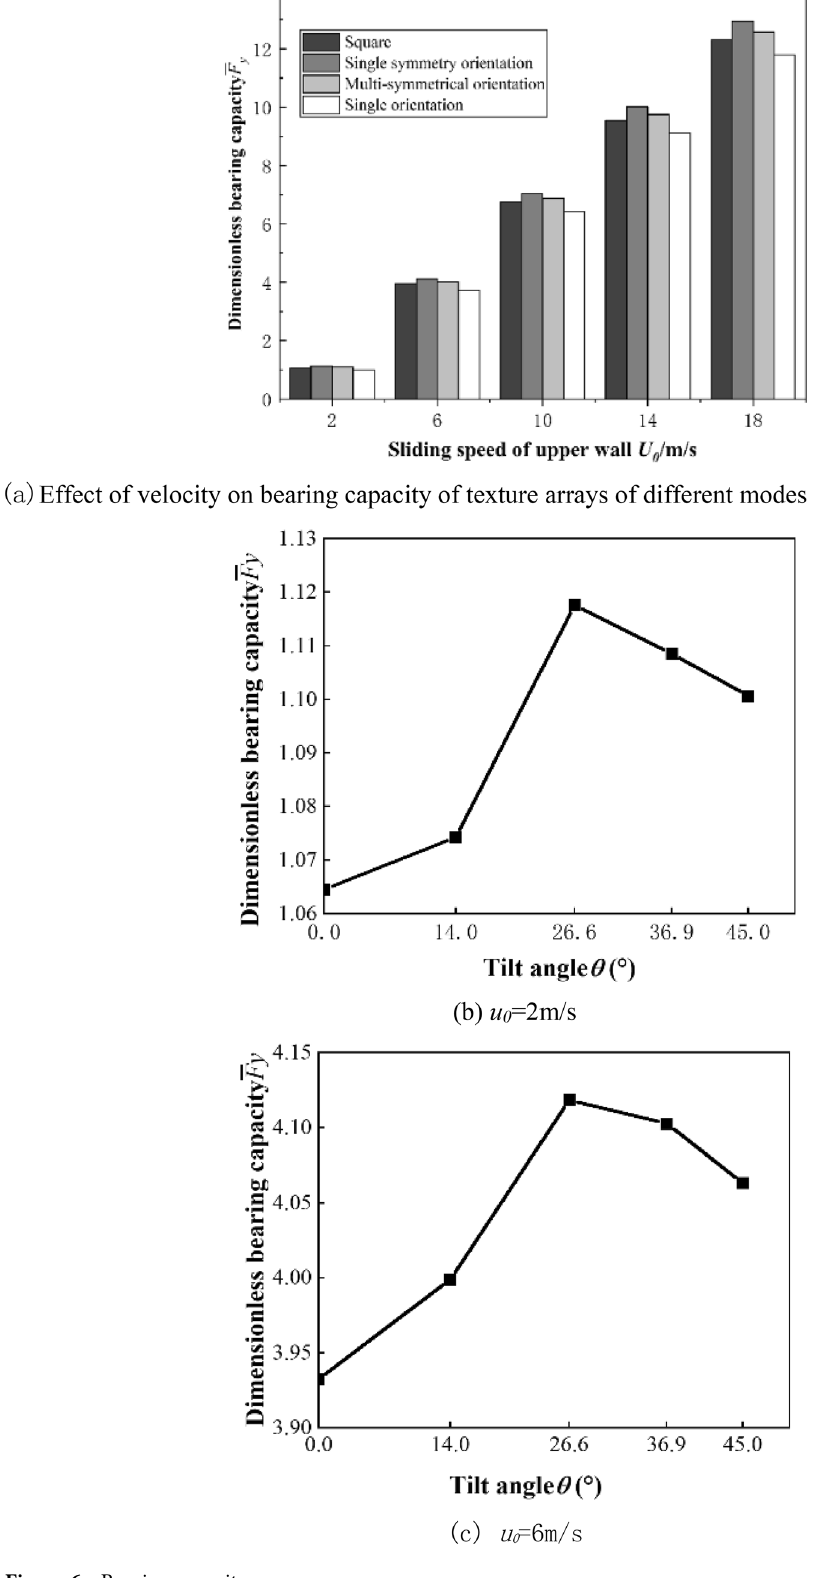
Figure 6. Bearing